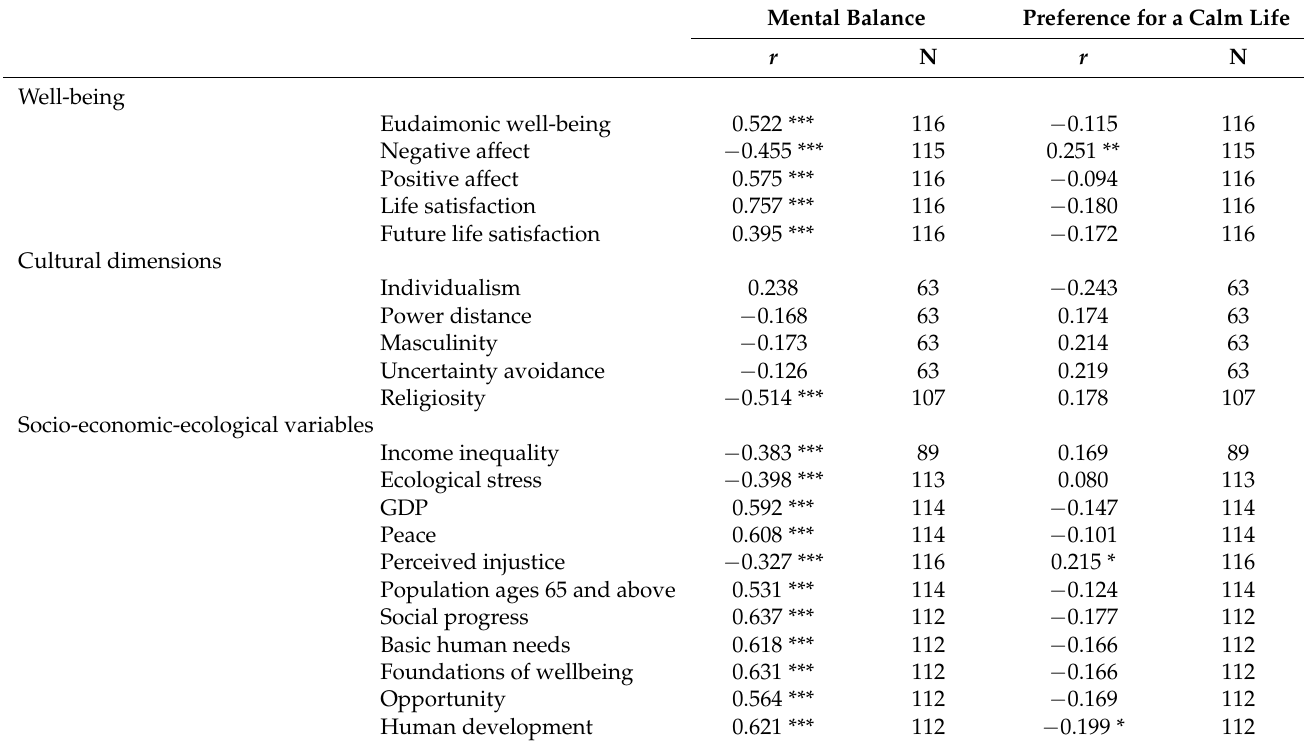
Table 1. Correlations between mental balance and preference for calm life and other national variables. Mental